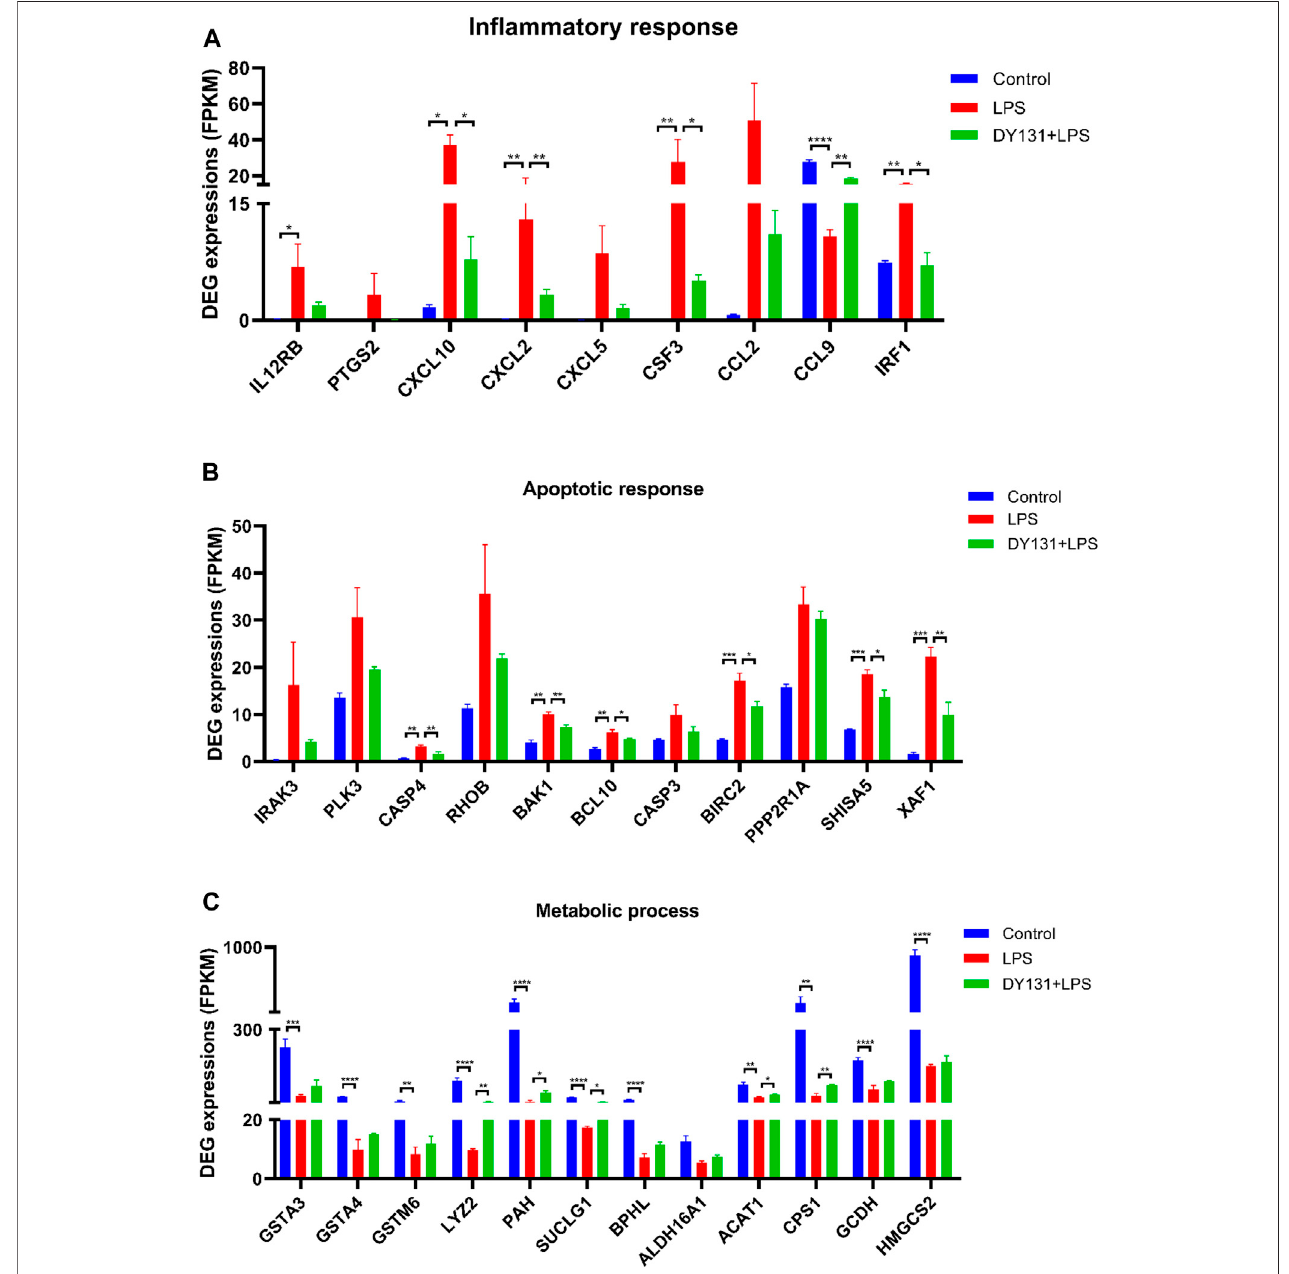
FIGURE8| Expressionpatternsofgenesinvolvedinthein fl ammation,apoptosisandmetabolism. (A) Genesrelatedtoin fl ammatoryresponse. (B) Genesinvolved inapoptosisresponse. (C) Genesassociatedwithmetabolicprocess.Datawerepresentedasmeans ± SEMaccordingtotheRNA-Seqresults(FPKMvalue).* p < 0.05, ** p < 0.01, *** p < 0.001 and **** p < 0.0001 vs. the indicated group (n (cid:1) 3 per